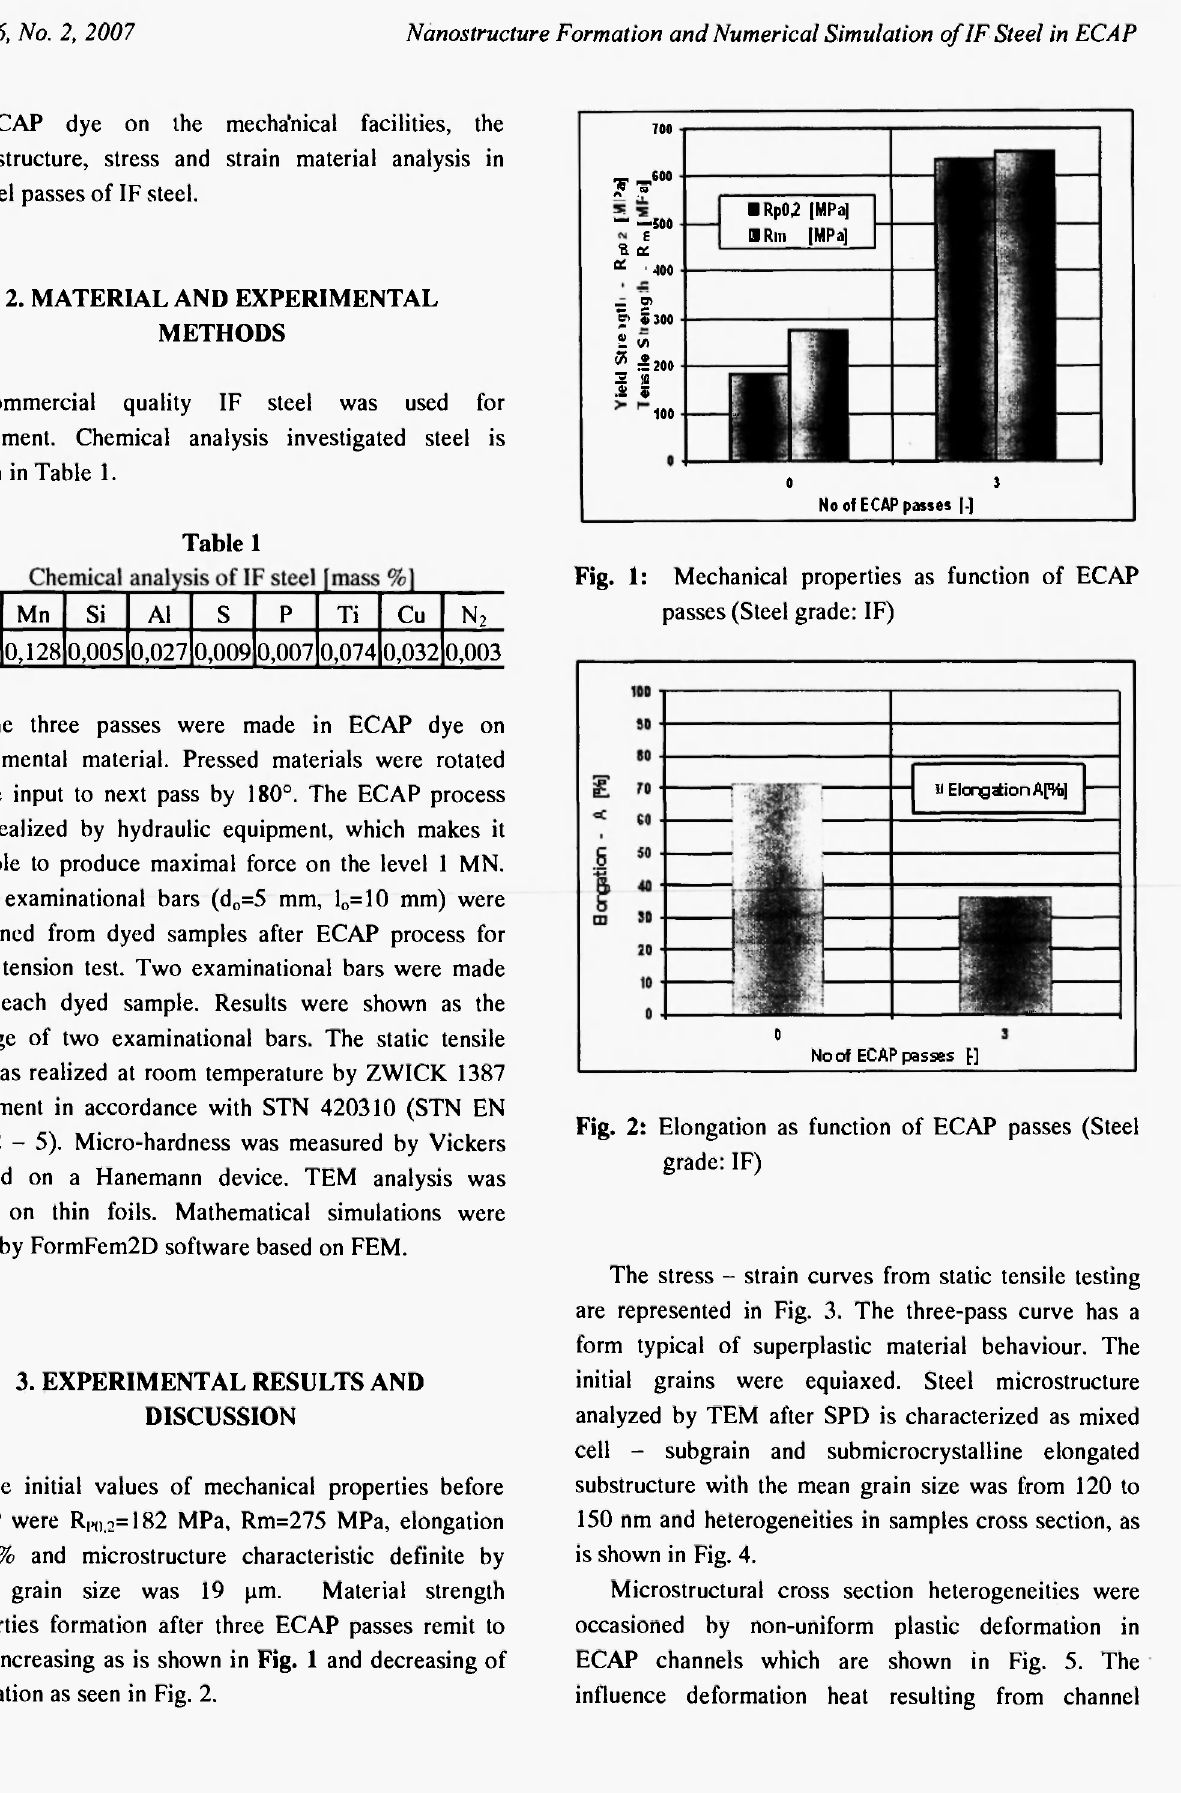
Fig. 1: Mechanical properties as function of ECAP passes (Steel grade: IF)